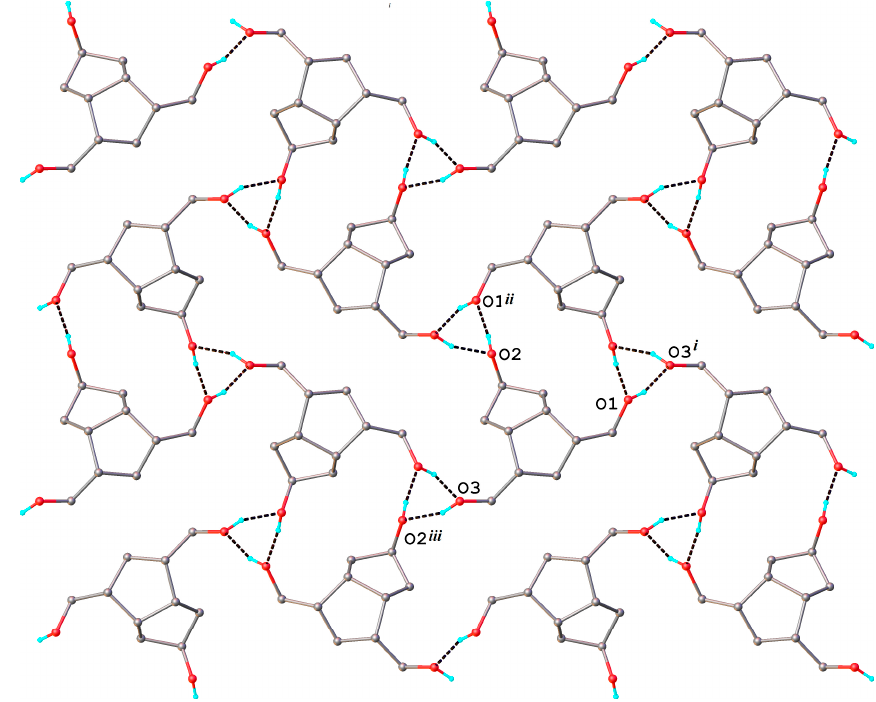
Figure 3. Three-dimensional supramolecular architecture in the crystal structure 8 .